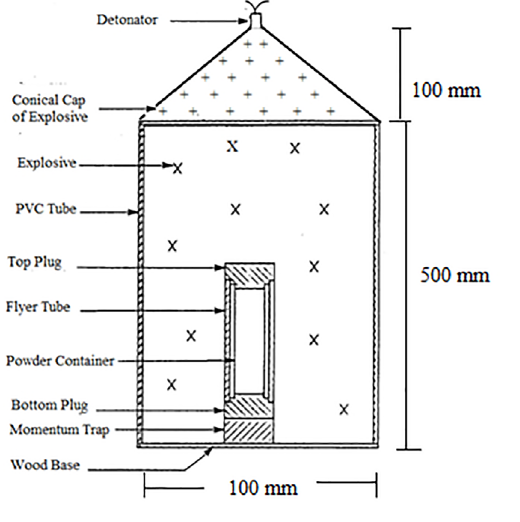
Figure 2. Schematic representation of the proposed device (adapted from Meyers 28 ), with the conical cap made of